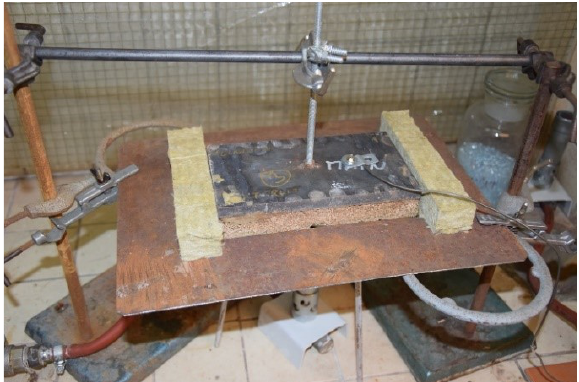
Figure 5. Experiment setup.